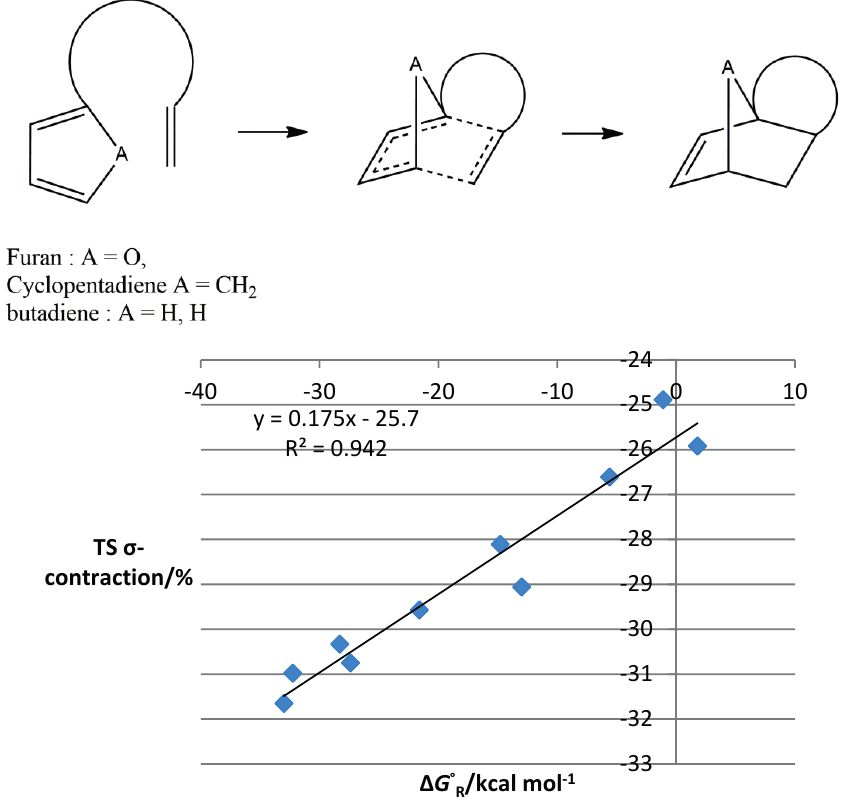
Figure 3. Plots of TS σ -contraction vs. key energetic parameters in computed intramolecular DA reactions 37 – 39 , 52 – 54 and 65 – 68 . ( a ) TS σ -contraction vs. Gibbs free energies of the reaction for new intramolecular DA reactions 37 – 39 , 52 – 54 and 65 – 68 ; ( b ) TS σ -contraction vs. reverse Gibbs free energy barrier for new intramolecular DA reactions 37 – 39 , 52 – 54 and 65 – 68 ; ( c ) TS σ -contraction vs. Gibbs free energy of activation for new intramolecular DA reactions 37 – 39 , 52 – 54 and 65 – 68